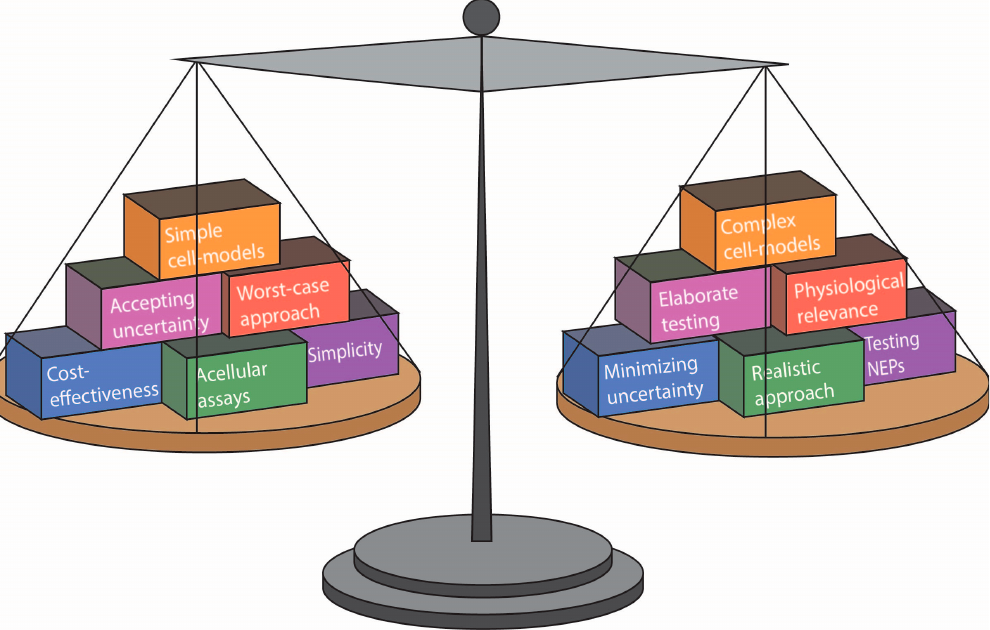
Figure 5. The balance of SbD hazard testing. SbD aims to address safety at an early stage in the product development process. On the one hand, SbD tries to be comprehensive to address all concerns, while on the other hand the approach should be simple.